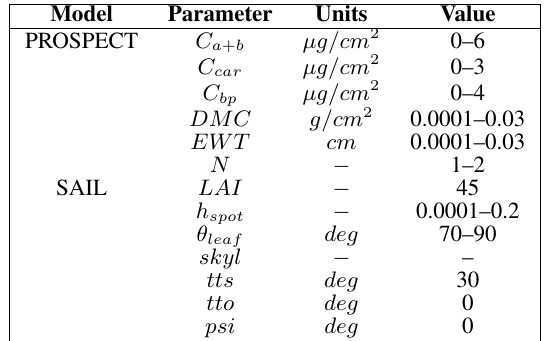
Table 1. Value or range of input parameters used in the PROSAIL model.